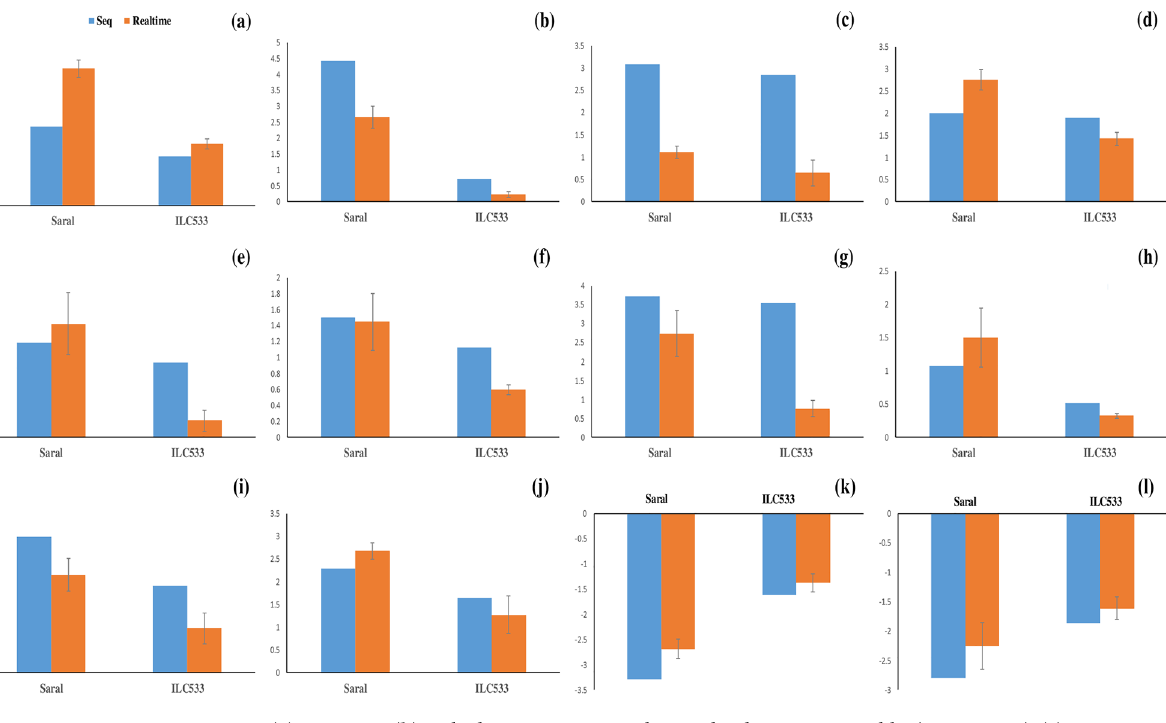
Figure 4. ( a ) CaMYB4, ( b ) Dehydration-responsive element-binding protein 1E-like (CaDREB1E), ( c ) CaNAC47, ( d ) CaTCP4, ( e ) WRKY transcription factor 33 (CaWRKY33), ( f ) Calcium-dependent protein kinase4 (CaCDPK4), ( g ) Heat stress transcription factor A-3 (CaHSFA3), ( h ) Mitogen-activated protein 4-like MKK2 (CaMAPK4), ( i ) Dehydrin COR47 (CaCOR47), ( j ) Late embryogenesis abundant protein3 (CaLEA3), ( k ) Protein phosphatase 2C 6 (CaPP2C6) . and ( l ) Polygalacturonase 1 beta-like protein 3